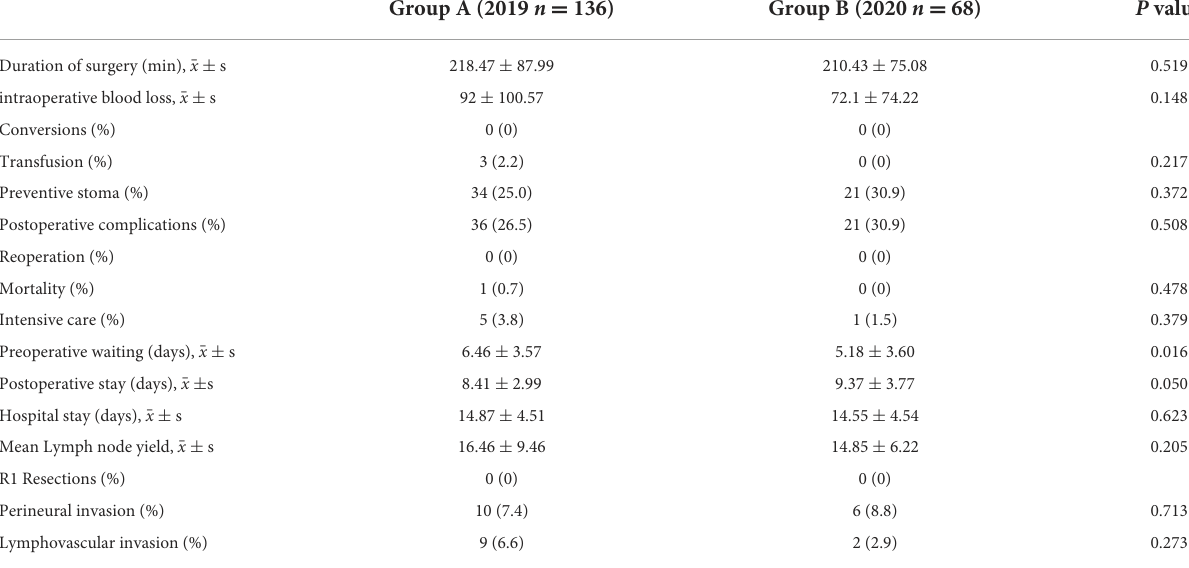
TABLE 2 Clinical parameters of patients who receive curative resection at the same period of 2019 and